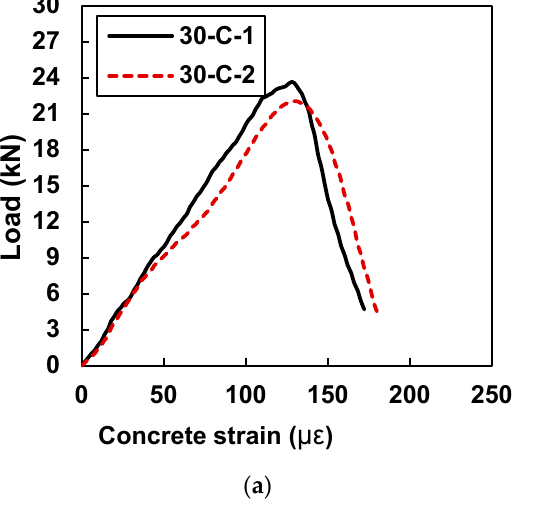
Figure 15. Load vs. strain curves for specimens with 30 mm CFRP strips (30-C-1 and 30-C-2): ( a ) strain in concrete and ( b ) concrete strain in CFRP.